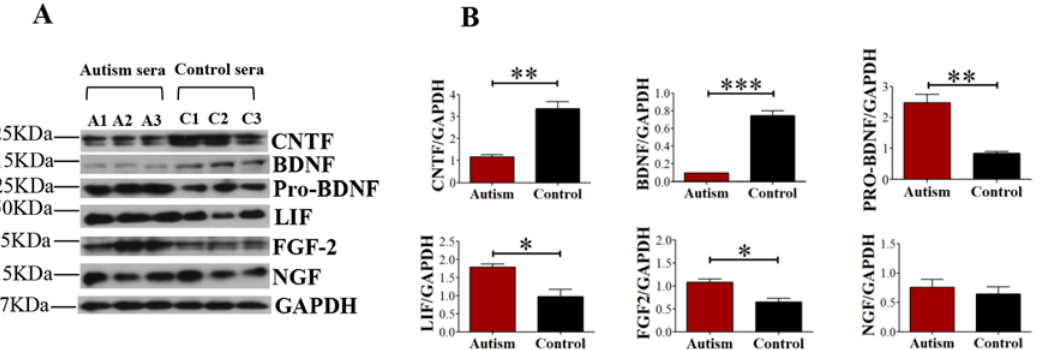
Fig 2. Levels of various neurotrophic factors in sera from autistic and control children. ( A and B ) Representative images and quantification of Western blots for evaluation of levels of various neurotrophic factors in 3 pairs of sera from autistic and control children used in the study are shown. A1, A2, A3, and C1, C2, C3, represent 3 autism and 3 control cases, respectively. * p < 0.05, ** p < 0.01, and *** p < 0.001. Student ’ s t